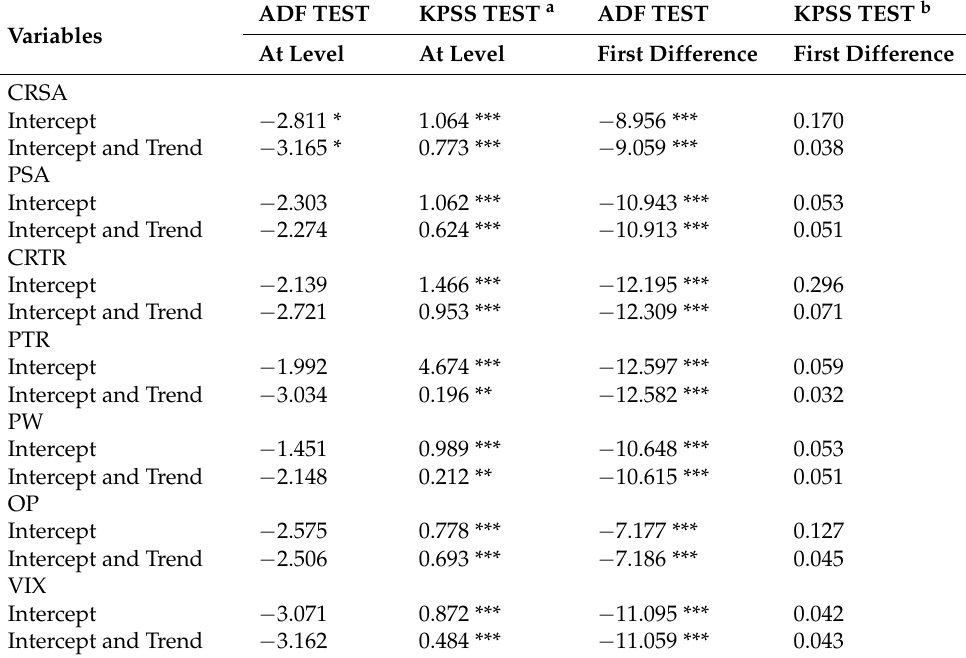
Table 3. Unit root test results of the variables.